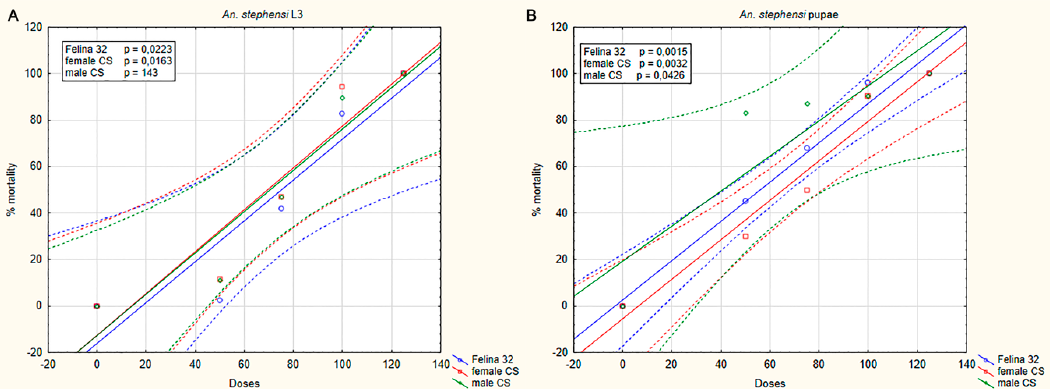
Figure 2. Dose–response curve of insecticidal activity of C. sativa essential oils (EOs) on An. stephensi preadults. Larvae ( A ) and pupae ( B ) were exposed for 24 h to different dilutions of hemp EOs (50, 75, 100, and 125 ppm). The level of susceptibility of both larvae and pupae to the EOs was found to be statistically significant (as reported in figure). EO samples, Felina 32 inflorescence; CS female inflorescence; CS male inflorescence.